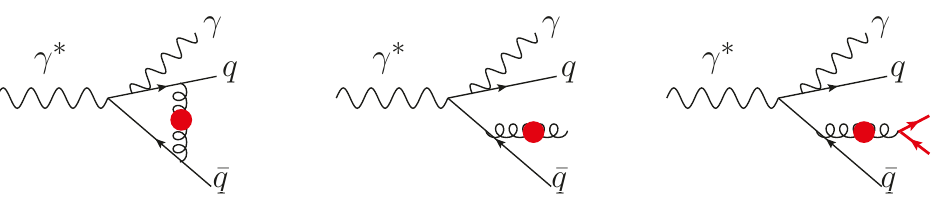
Figure 4 . An example of a virtual, a real gluon emission and a real q ¯ q emission graph contributing to the large- n f correction to the process γ ∗ → q ¯ qγ . The right graph, with a g → q ¯ q splitting, must be included, since the sum over final state quark flavour leads to a factor of n f